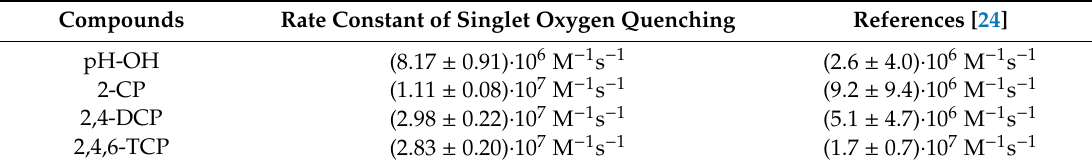
Table 2. Percentages of elements of analyzed carriers.